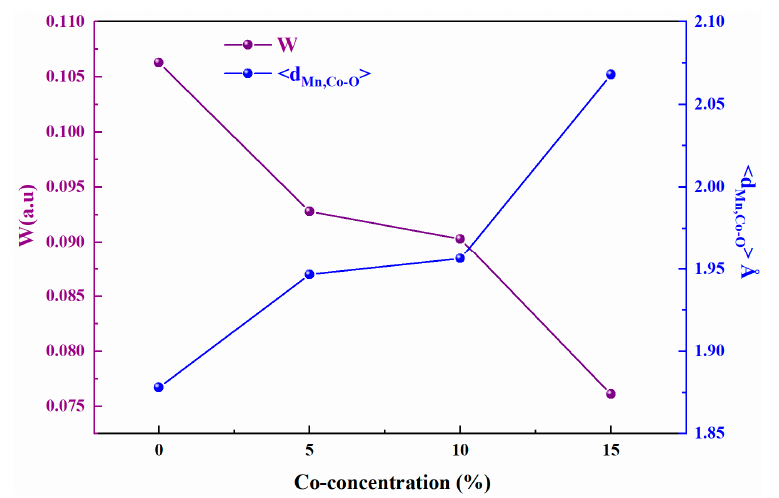
Figure 3. Variation of the bandwidth W and interatomic distance as a function of the Cobalt rate for Pr 0.7 Sr 0.3 Mn ( 1 − x ) Co x O 3 (0 ≤ x ≤